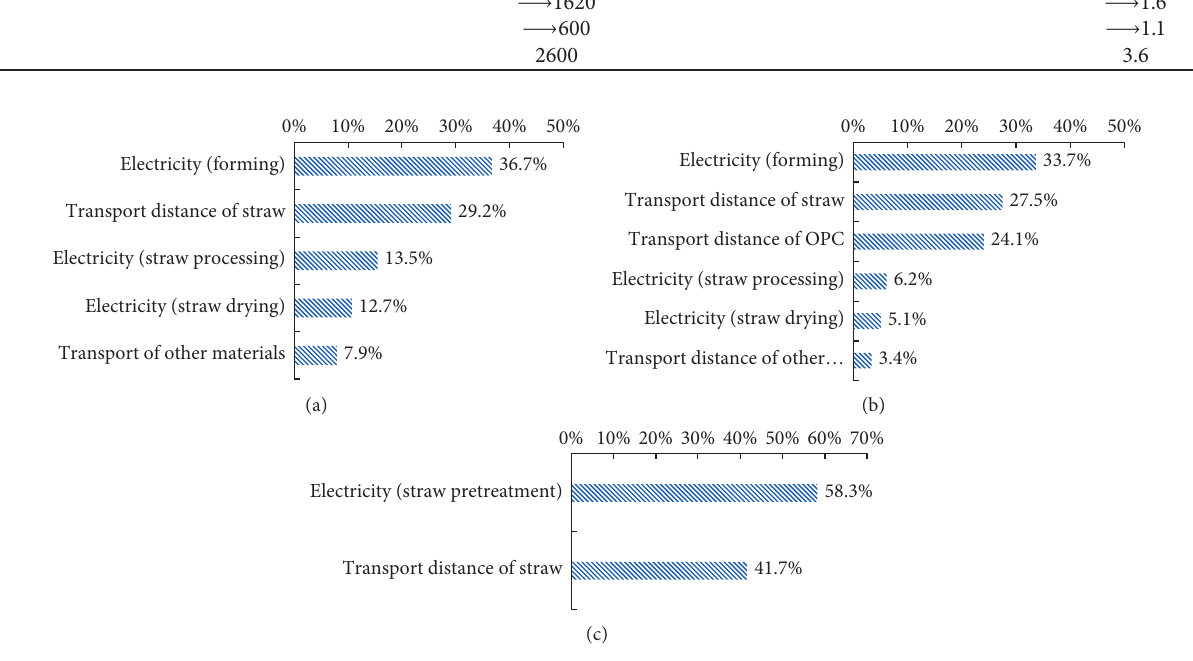
Figure 11: Sensitivity analysis of contribution to variance in greenhouse gas emissions of Scenario 1 (a), Scenario 2 (b), and Scenario 3 (c).